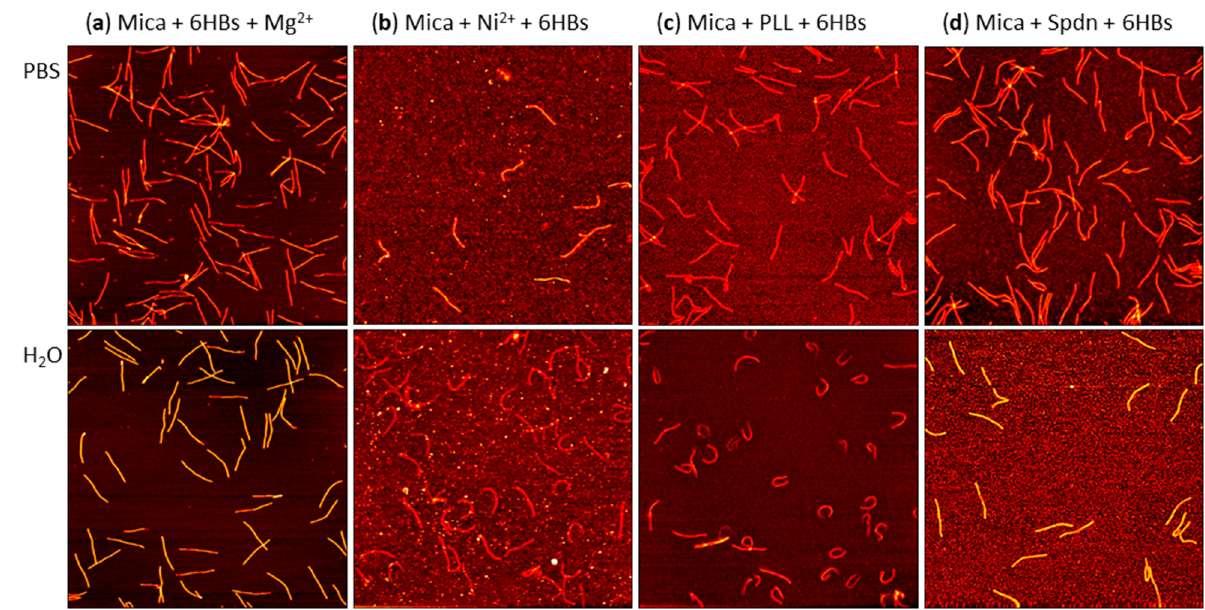
Figure 8. Representative AFM images of 6HB DONs adsorbed at mica surfaces from PBS (upper row) and H 2 O (lower row) via ( a ) Mg 2+ addition, ( b ) Ni 2+ pretreatment, ( c ) PLL pretreatment, and ( d ) Spdn pretreatment. The AFM images have a size of 3 x 3 µm² and a height scale of 4 nm.